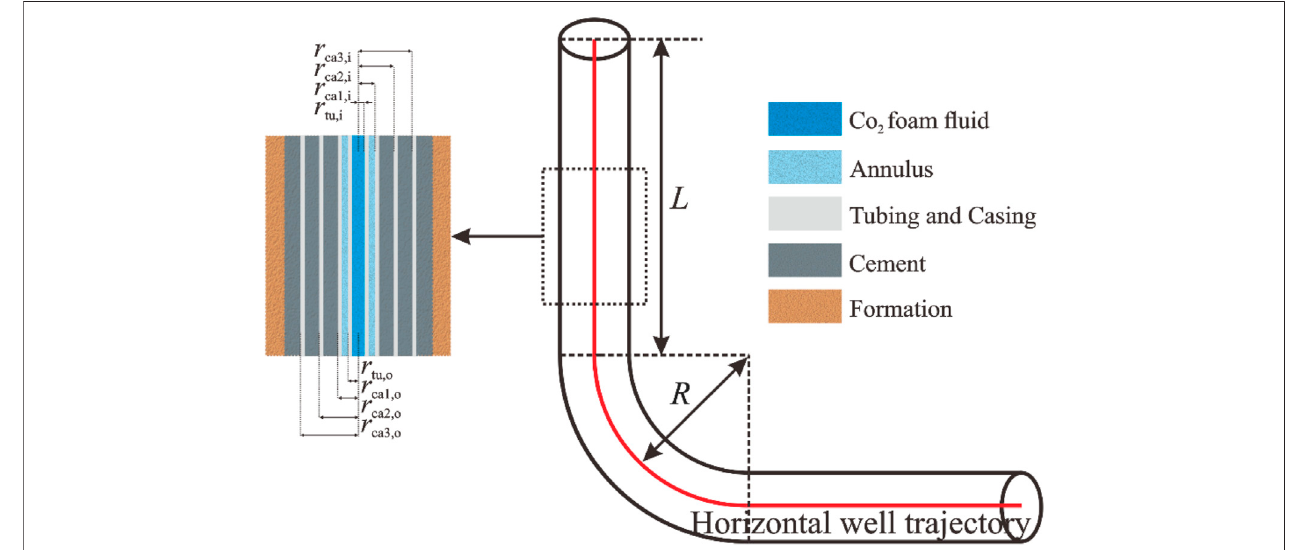
FIGURE 1 | Diagram of the wellbore-formation system for CO 2 foam fracturing fl